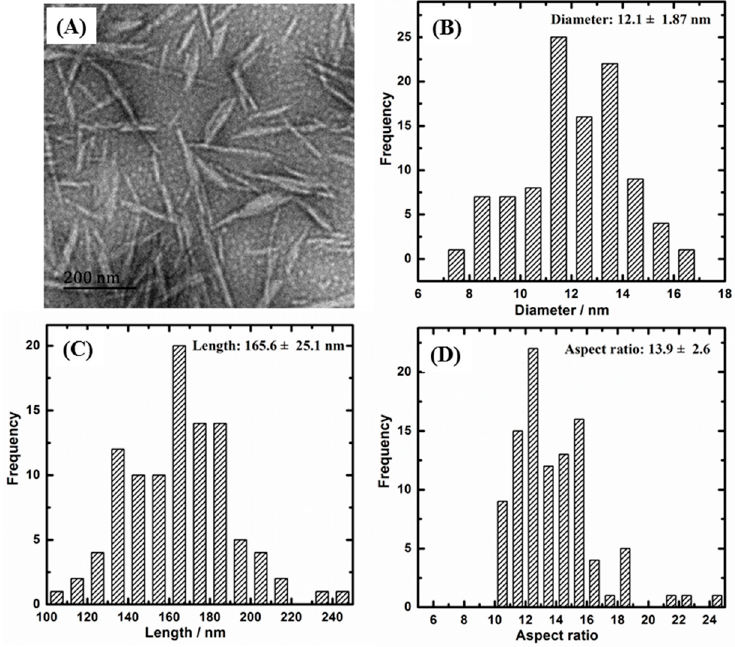
Figure 1. ( A ) TEM image of wood CNC (CNC-A) and its size statistics of ( B ) diameter, ( C ) length, and ( D ) aspect ratio. CNC, cellulose nanocrystal.